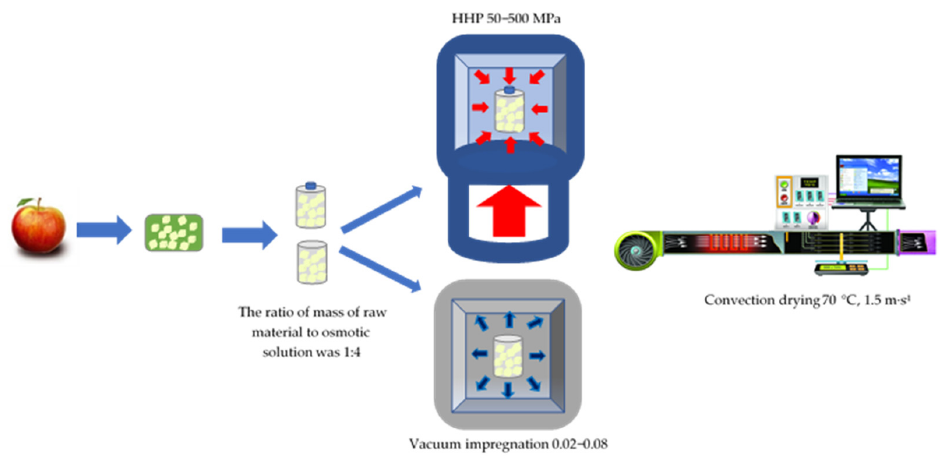
Figure 1. The diagram of the conducted experiments.